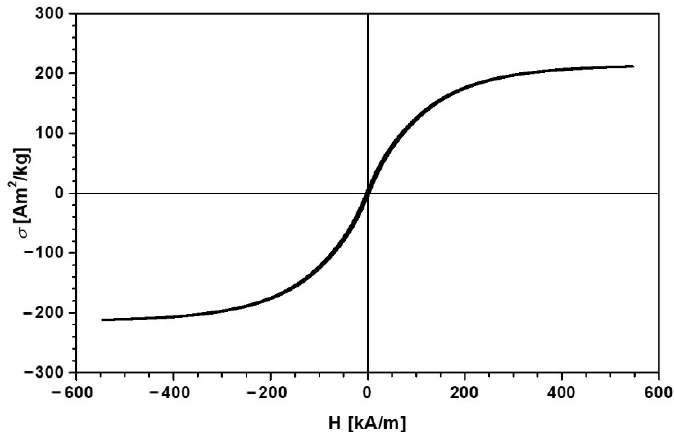
Figure 1. Magnetization slope for Fe microparticles. At 295 K , the dynamic viscosity of the silicone oil (MS100; Silicone Commerciale SpA, Gambellara, Italy) is η 0 = 97 · 10 − 3 Pa · s and the density is ρ Fe = 970 kg/m 3 . The GB fabric (textile.ro), with a thickness of d GB = 1.80 mm, has an appearance as shown in Figure 2a. GB fabric is made from cotton fibers by weaving the warp threads at right angles to the weft